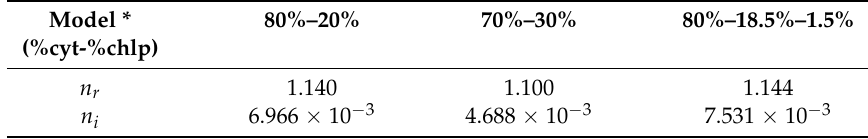
* The percentages represent the relative volume of the model cytoplasm and